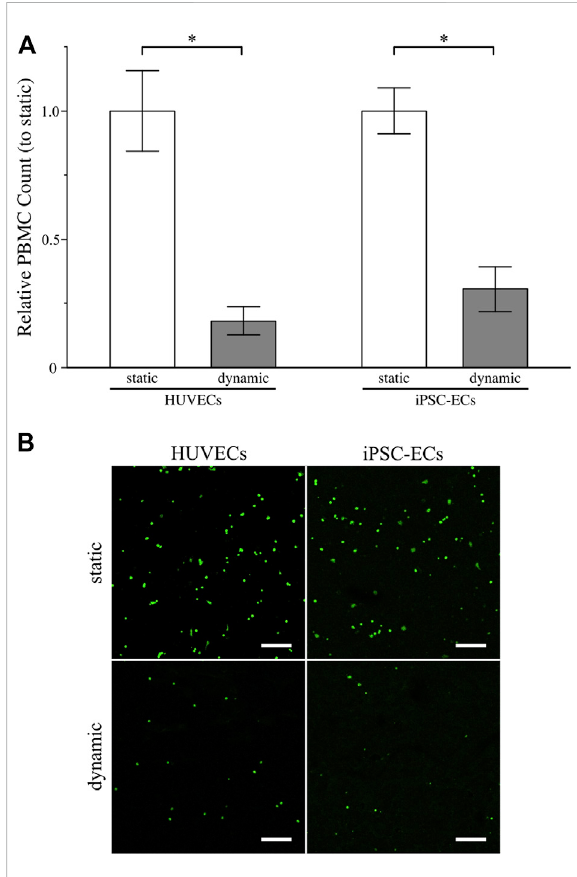
FIGURE 7 Assessment of glycocalyx functionality of HUVECs and iPSC- ECs after 96 h of static and dynamic culture via PBMC adhesion assay. (A) Relative PBMC count determined from confocal images (for details on image processing refer to Supplemental Figure S6A). Data are presented as mean ± SEM with respect to “ static ” ( n = 4, Mann-Whitney Test, * p < 0.05) (B) Representative unprocessed confocal images of adherent PBMCs labelled with CMFDA on the surface of con fl uent HUVEC and iPSC-EC monolayers. (Scale Bars: 200